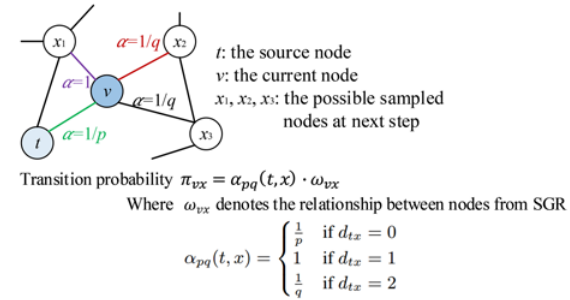
Figure 2. Illustration of the biased 2nd random walk procedure in node2vec: It shows that how hyper-parameters p and q guide the walk between BFS and